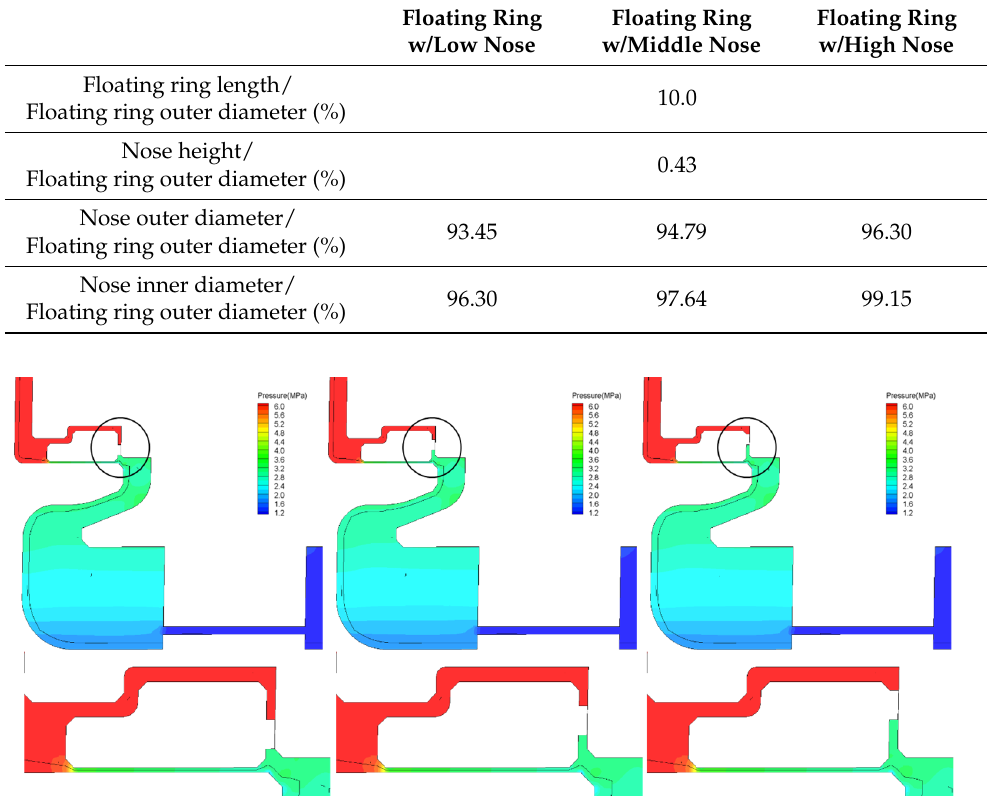
Figure 13. Velocity (m/s) distributions with change in nose height.